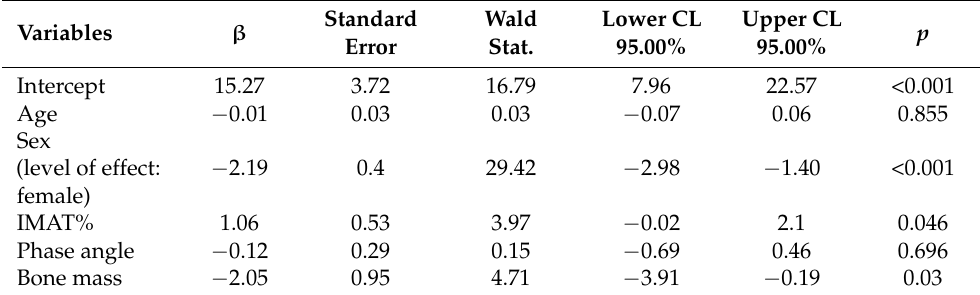
Table 4. Estimates of the probability for OSA occurrence based on body composition (Logit step- wise